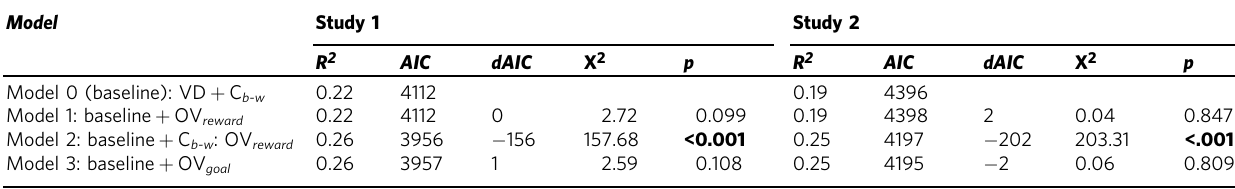
Table 2 Model comparison for OV reward and OV goal effects on RT across studies